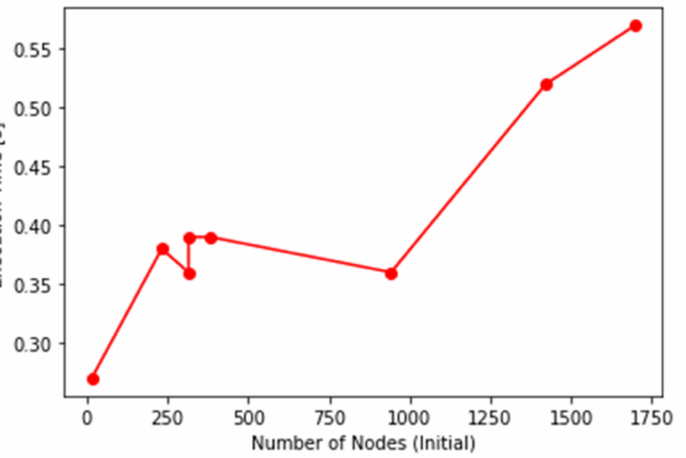
Figure 13. Execution time of the locking algorithm against the number of nodes after the final stage of locking for different values of k and h .